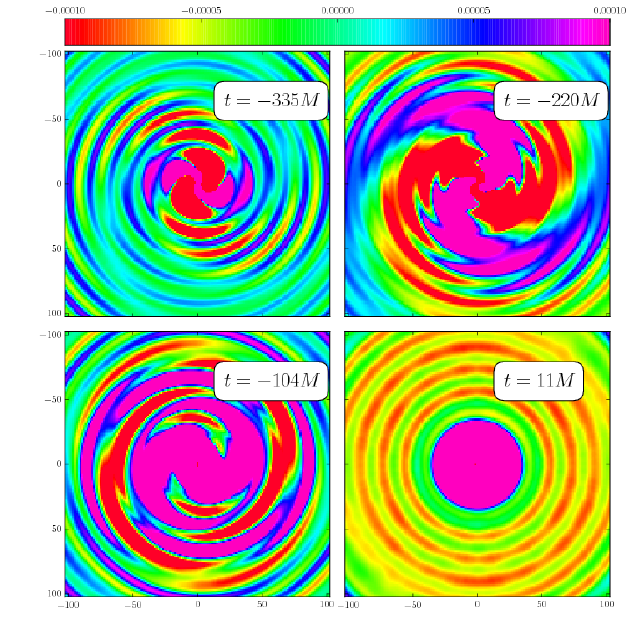
Figure 4 . Di(cid:11)erence in the conformal factor (cid:31) on the orbital plane between an inspiral with A = 0 : 5 , R 0 = 0 : 3 M , and M (cid:10) = 0 : 5 and the run without quantum (cid:13)uctuations. The black hole binary rotates clockwise and has merged by the (cid:12)nal frame shown. The colormap is the same for all frames and has been chosen to emphasize the far zone. Note the change in character of the far-zone behavior after the merger, where the di(cid:11)erence radiates